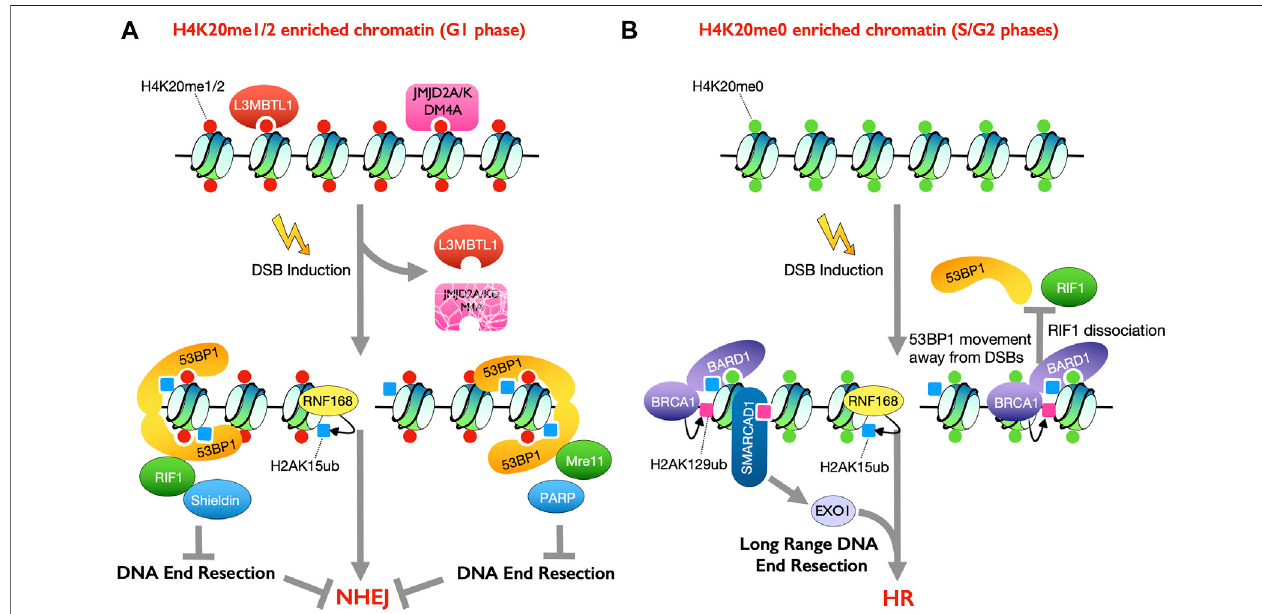
FIGURE 1 | Histone modi fi cations involved in dictating the cell cycle phase speci fi c DSB repair pathway choice. (A) Histone mark H4K20me1/2 is enriched in G1 phase ofthe cell cycle.53BP1 binds to nucleosomescontaining both H4K20me1/2 and H2AK15ub, mediated byRNF168 upon DSB induction, to promote DSB repair byNHEJ (B) Unmethylated H4K20me0isenriched inS/G2phasesofthecellcycle.BRCA1-BARD1heterodimerrecognizesH4K20me0andH2AK15ubtofacilitateHR repair (right). BRCA1 mediated H2AK129ub recruits SMARCAD1 to promote DNA end resection and thus HR (left).